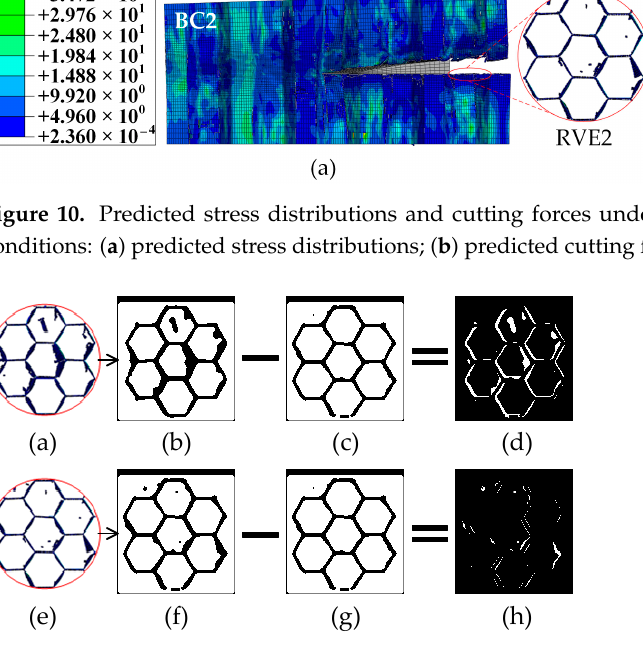
Figure 11. Calculating method of damage areas for two BC configurations: ( a ) damaged RVE1 with BC1; ( b ) greyscale image of the RVE1; ( c ) undamaged image of the RVE1; ( d ) damaged area of the RVE1; ( e ) damaged RVE2 with BC2; ( f ) greyscale image of the RVE2; ( g ) undamaged image of the RVE2; ( h ) damaged area of the RVE2.